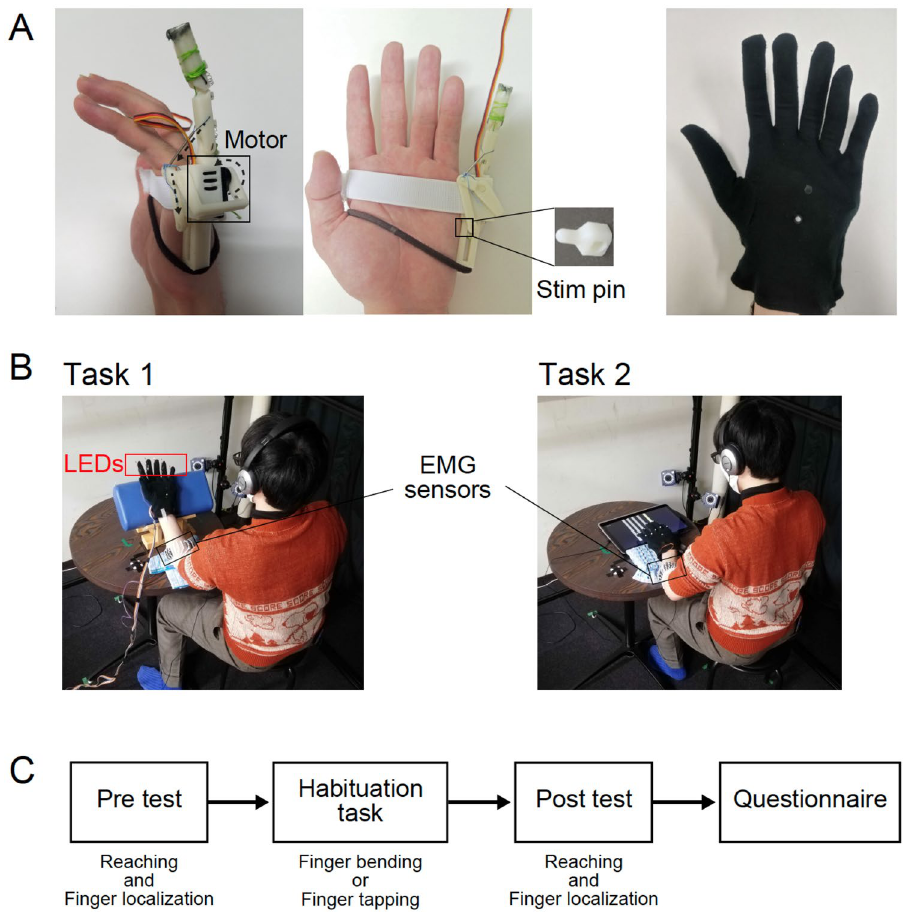
Figure 1. The robotic sixth finger setup and experiment. ( A ) The 3D-printed robotic sixth finger actuated by a servo motor in the chassis. The entire arrangement is designed to be strapped onto the hand of participants, near their left little finger. The right photo is a six-fingered glove worn by a participant with the robotic finger attached. ( B ) Schematic of the habituation task. In task 1, participants wore a glove with LEDs fixed on the tip of the glove fingers. They bent the finger corresponding to the LED that lit up. In task 2, a tablet PC on the desk displayed a piano-like key under each of the five fingers (including the robotic finger, and except the thumb). The participants pressed the key that lit up. Both tasks were aligned with the beats of popular music that were played in the headphones of the participants. ( C ) The experiment paradigm. The participants worked in two conditions: controllable and random. In each condition, they started with two pre-tests to measure specific body representations (explained later in the text), followed by the habituation, then two post-tests, and finally ending with a questionnaire (see Fig. 2) to assess their cognitive percept. The photos in ( A , B ) were taken by Yui